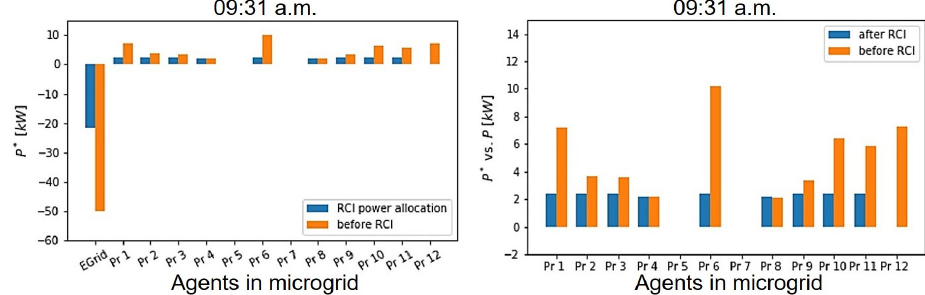
Figure 6. Power trades before and after RCI algorithm congestion correction. ( Left ): All agents are shown. ( Right ): Only prosumers’ power set points. Time step: 09:31 a.m. P * is referred as the optimal power set point found by the RCI algorithm, whereas P is referred to each prosumer’s required power set point before the application of the RCI algorithm.